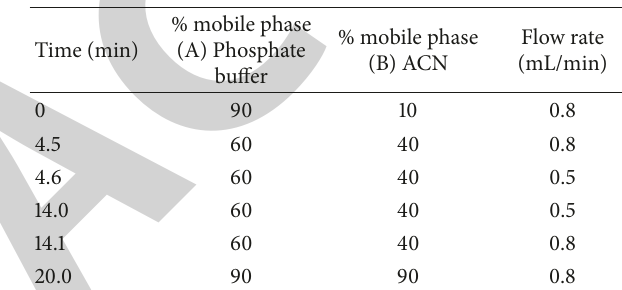
Table 1: Summary of gradient